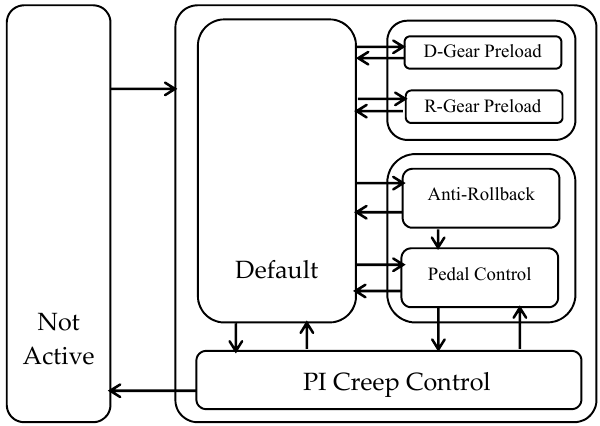
Figure 6. Control Flow Diagram of State Machine.